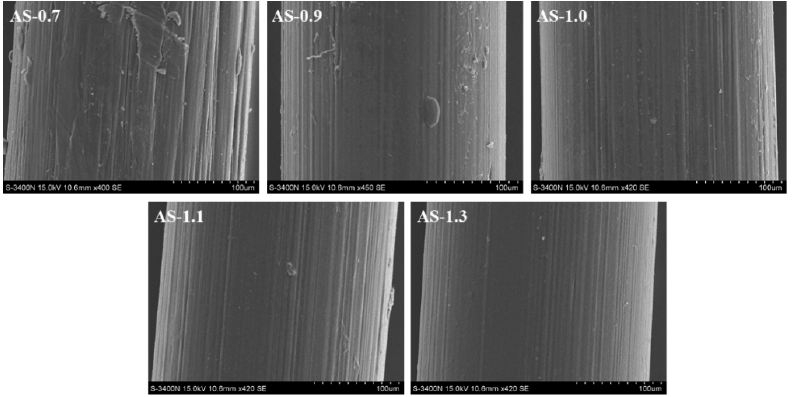
Figure 6. Effects of chitosan’s M V on residual ratio ( a ) and BSR ( b ) of its monofilament with enzymatic hydrolys.